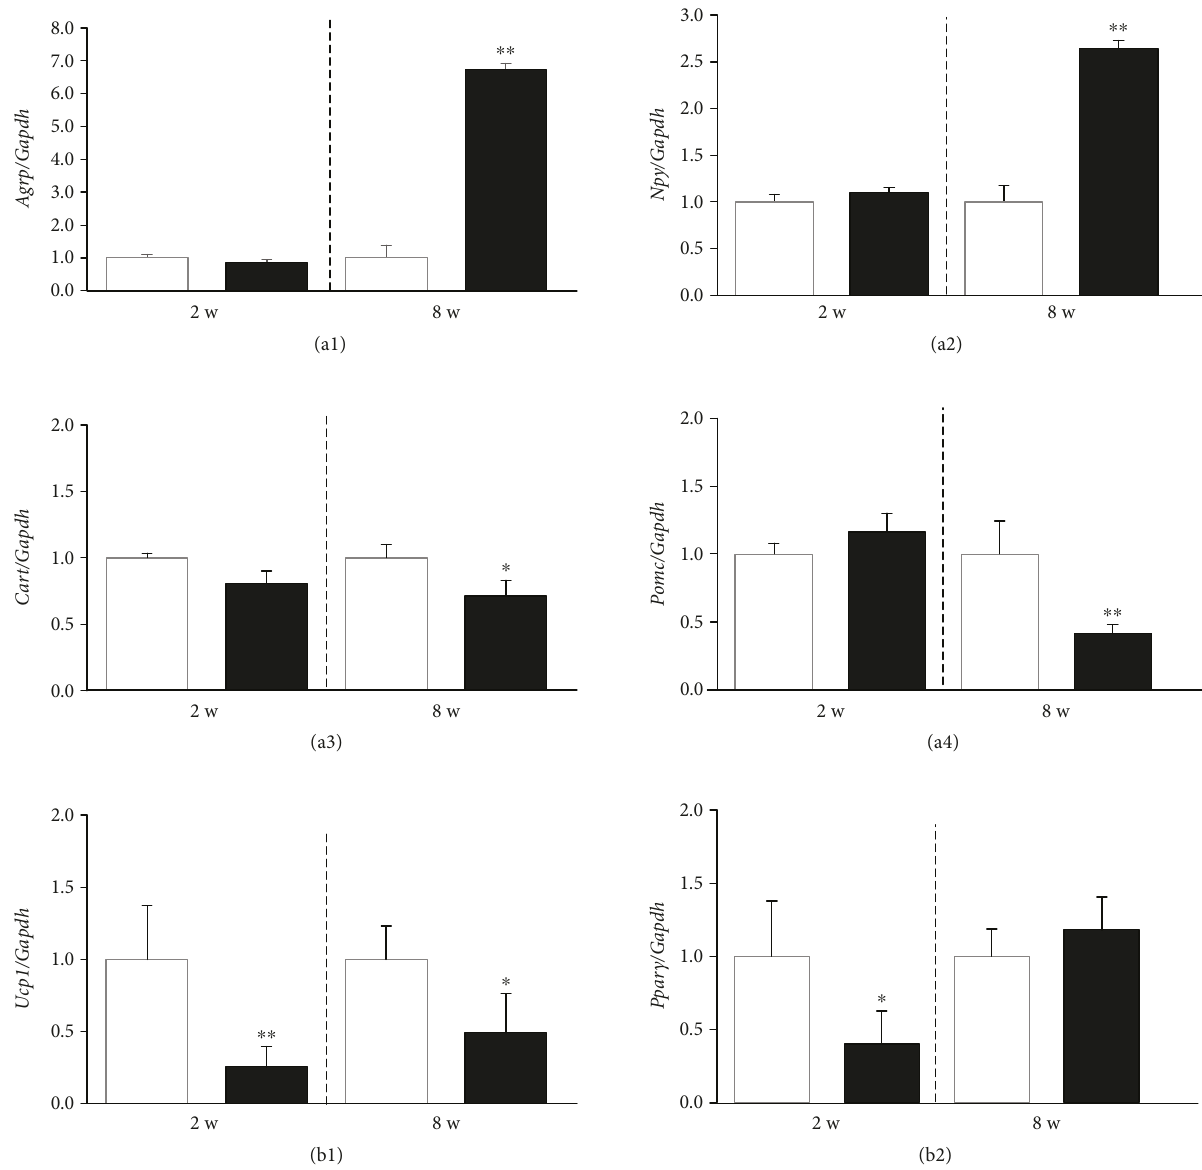
Figure 2: Expression of genes related to food intake and thermogenesis regulation in the hypothalamus and brown adipose tissue (BAT). Expression of genes in the hypothalamus are shown (a). Agrp (a1), Npy (a2), Cart (a3), and Pomc (a4) expression levels are displayed relative to Gapdh mRNA levels. Expression of genes related to thermogenesis in BAT (b). Ucp1 (b1) and Ppar γ (b2) mRNA levels are displayed relative to Gapdh mRNA levels. The sample size of all groups is 7-8. The values are the mean +SE. The values are expressed as the fold change relative to WT mice at the respective age (all values were set to 1.0). Open columns and closed columns represent WT ( +/+ ) mice and db/db mice, respectively. The data were analyzed statistically by unpaired Student ’ s t -test. ∗ P < 0 05 , ∗∗ P < 0 01 compared with WT mice at the respective